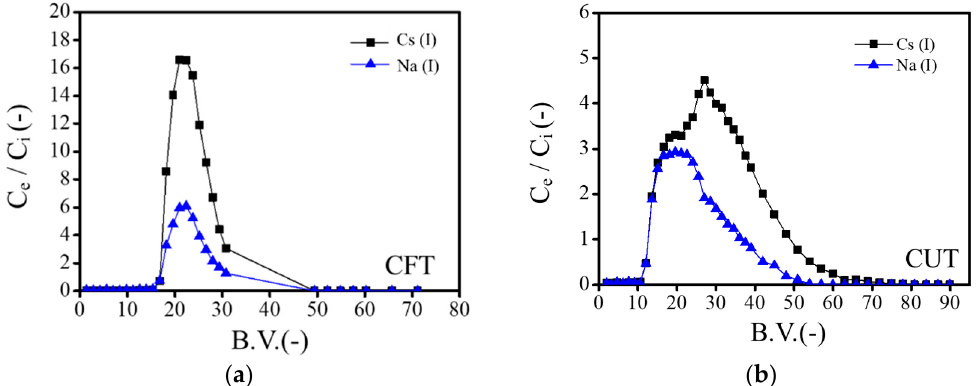
Figure 9. Elution profiles of the adsorption of Cs + and Na + ion on ( a ) crosslinked fresh tea leaves (CFT) adsorbents and ( b ) crosslinked used tea leaves (CUT) adsorbents with HCl solution, pH = 1.9, flow rate = 4.68 cm 3 h − 1 (CFT), 4.62 cm 3 h − 1 (CUT).